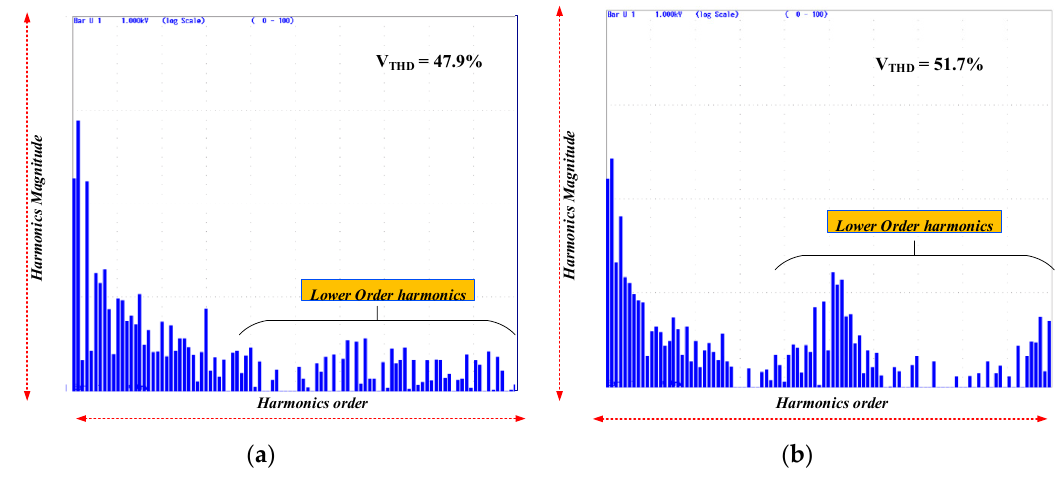
Figure 13. Excremental results MCRSVPWM: ( a ) Harmonics spectrum of V AB at M a = 0.6, ( b ) Harmonics spectrum of V AB at M a = 0.9.